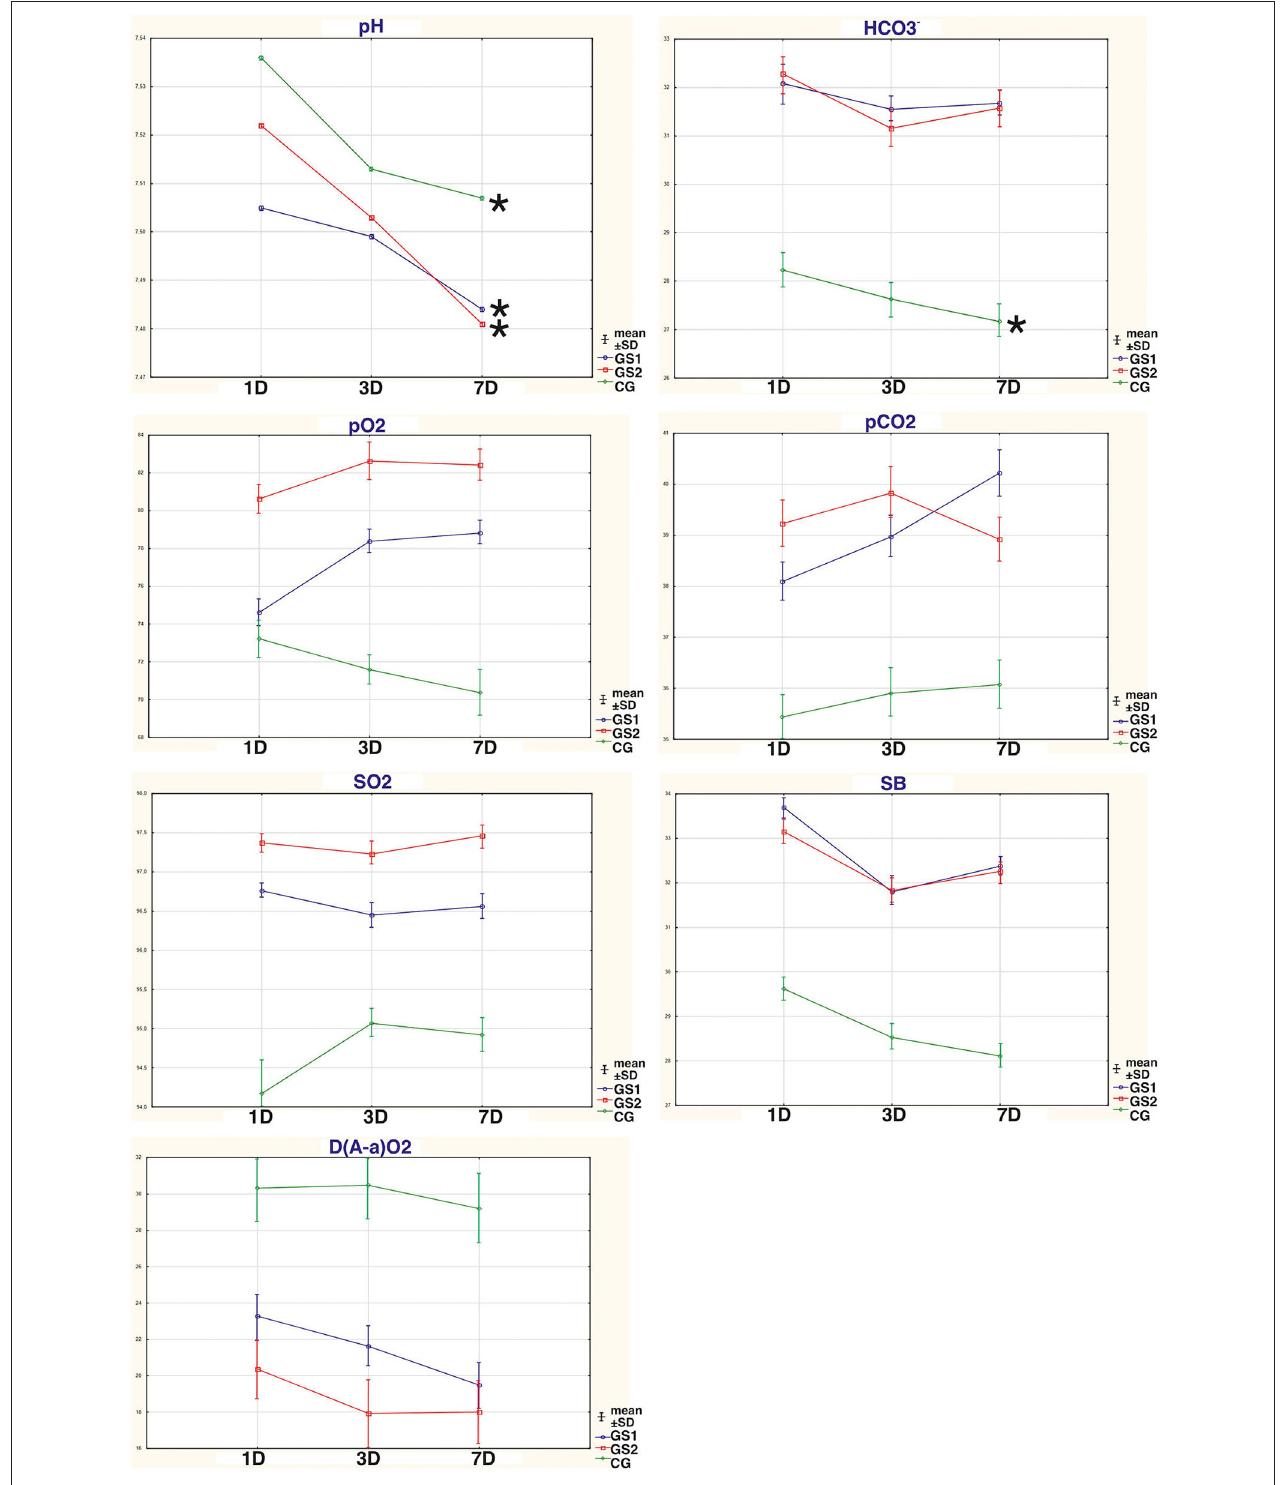
FIGURE 1 | The dynamic changes in the acid-base parameters that are most important to the discussion: pH, partial pressure of carbon dioxide (pCO 2 ), partial pressure of oxygen (pO 2 ), oxygen saturation (SO 2 ), bicarbonate level (HCO 3 ), standard bicarbonate (SB), and alveolar-arterial gradient (D(A-a)O 2 ), in the blood of persons suffering from AWS that had standardized drug therapy (SDT), non-compressed oxygen therapy (NOT), and hyperbaric oxygenation (HBO); CG, patients who underwent SDT only (control group); SG1, patients who underwent SDT in combination with NOT; SG2, patients who underwent SDT in combination with HBO; 1D, first day of therapy; 3D, third day of therapy; 7D, seventh day of therapy; *significant differences within the group p < 0.05 ( t -test).